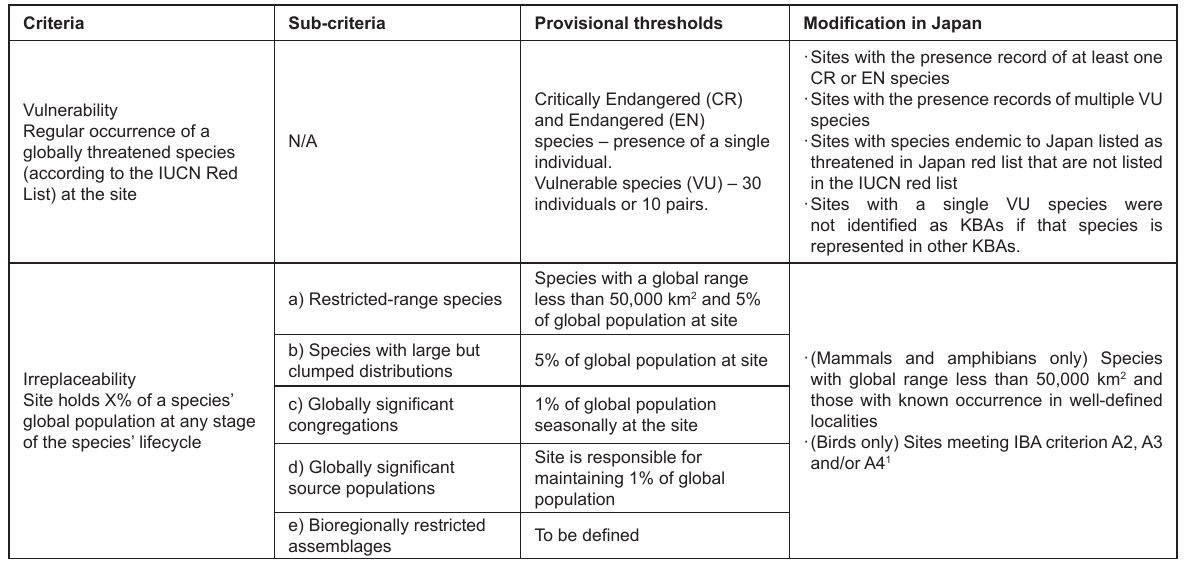
Table 1. KBA criteria and their application in